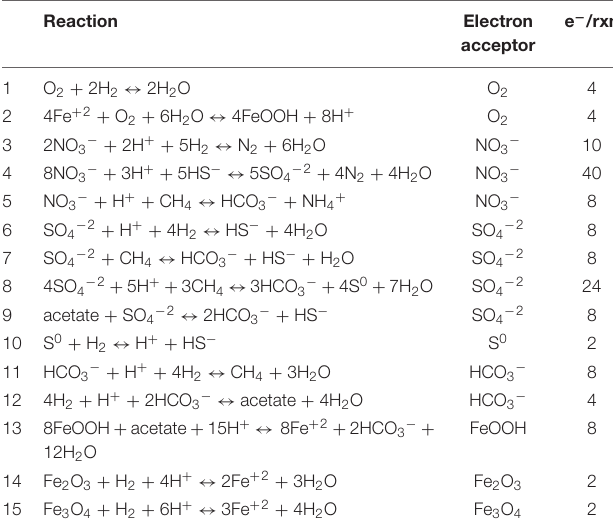
TABLE 1 | Reactions considered in estimations of Gibbs Free Energy of Reaction shown in Figure 2 . Aqueous forms were used for O 2 , CH 4 , H 2 , N 2 . Reaction Electron